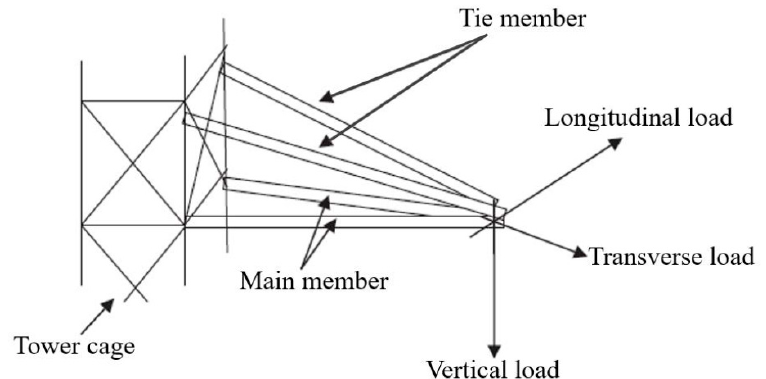
Figure 3. Location of cross arm in transmission tower with its forces acting on it [6].